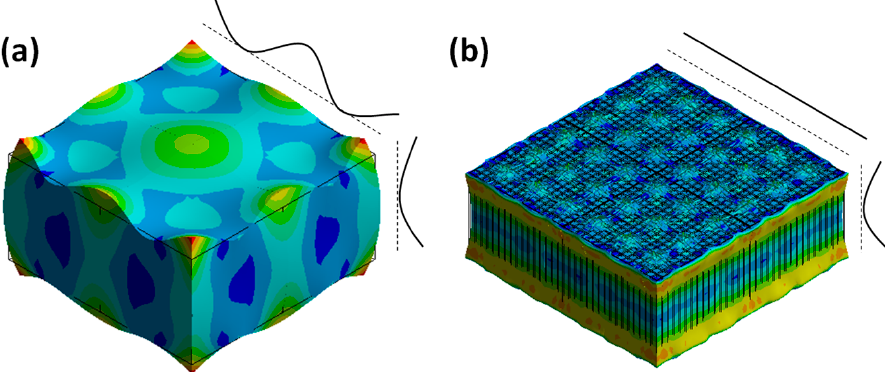
Figure 10. Vibration mode shapes at the operation frequency (2 MHz) of ( a ) the single-phase and ( b ) the 1–3 composite transducers, where the solid and the dashed lines denote the mode shapes and the neutral line.